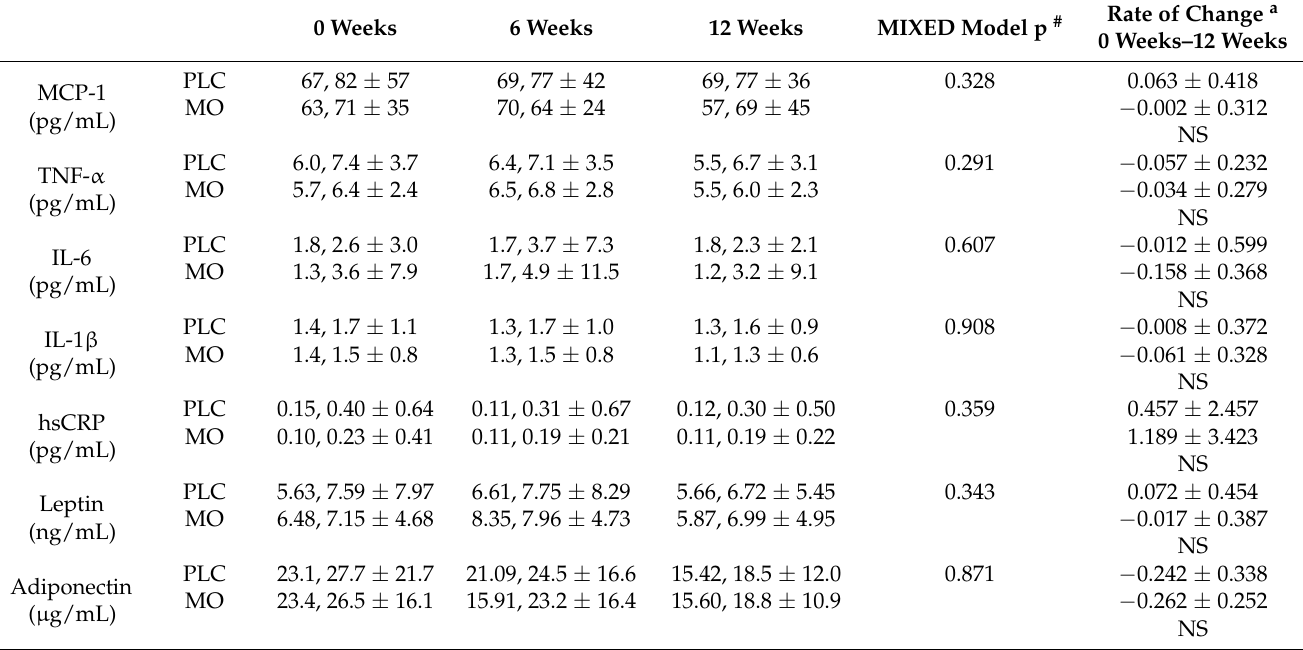
Table 3. Inflammatory markers and adipokines in patients with prediabetes of the PLC and MO groups during the intervention.